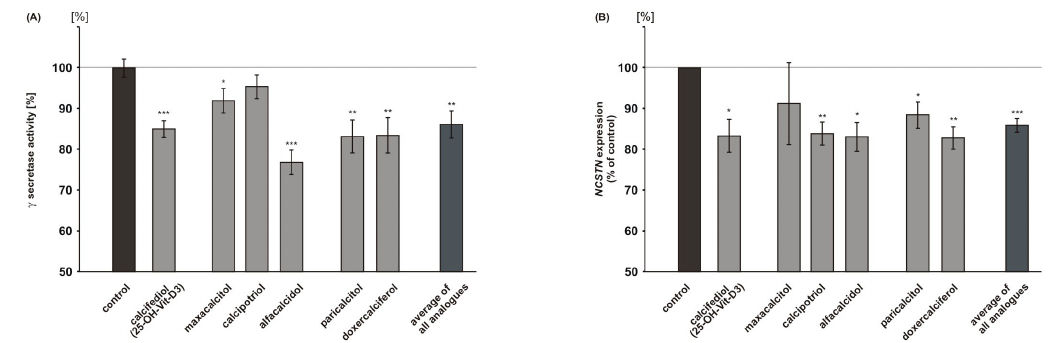
Figure 3. Effect of vitamin D and analogues on γ -secretase. ( A ) Analysis of γ -secretase activity in living SH-SY5Y wt cells ( n ≥ 5). ( B ) mRNA level of the γ -secretase component nicastrin determined by RT-PCR analysis ( n = 3). Error bars represent the standard error of the mean. Asteriks show the statistical significance calculated by unpaired Student’s t test (* p ≤ 0.05; ** p ≤ 0.01; *** p ≤ 0.001).